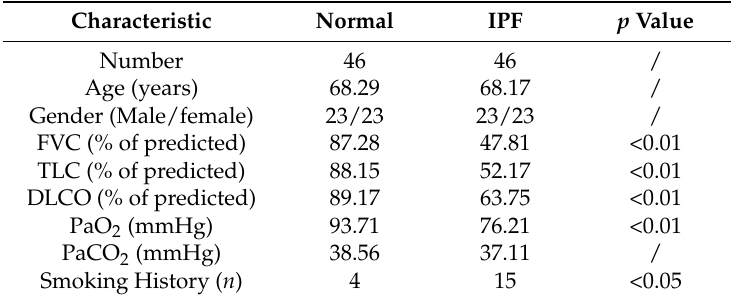
Table 1. Characteristics and physiologies of idiopathic pulmonary fibrosis (IPF) patients and the normal individuals.